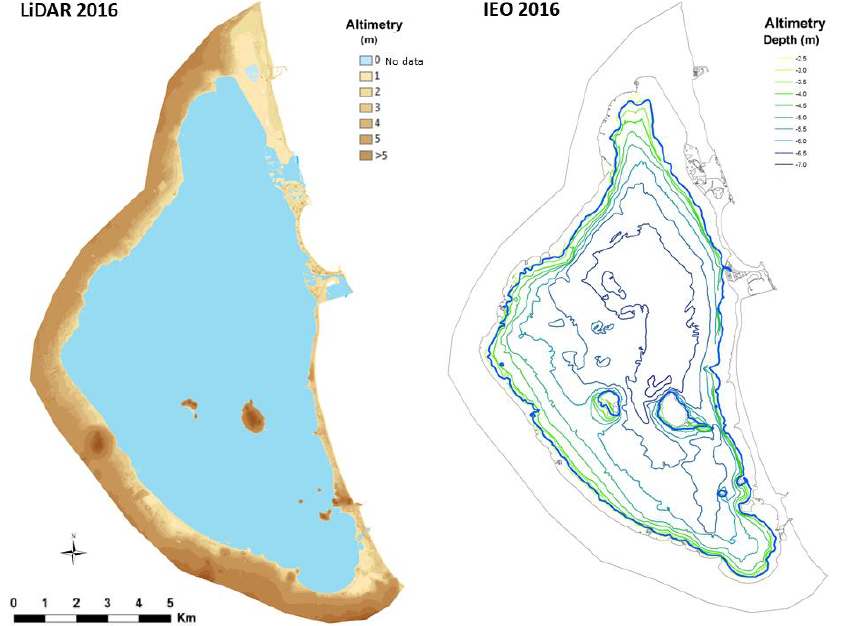
Figure 6. LiDAR data (2016) around the Mar Menor lagoon and IEO bathymetry [14] in 2016 (no data for a depth < −3 m, blue line).